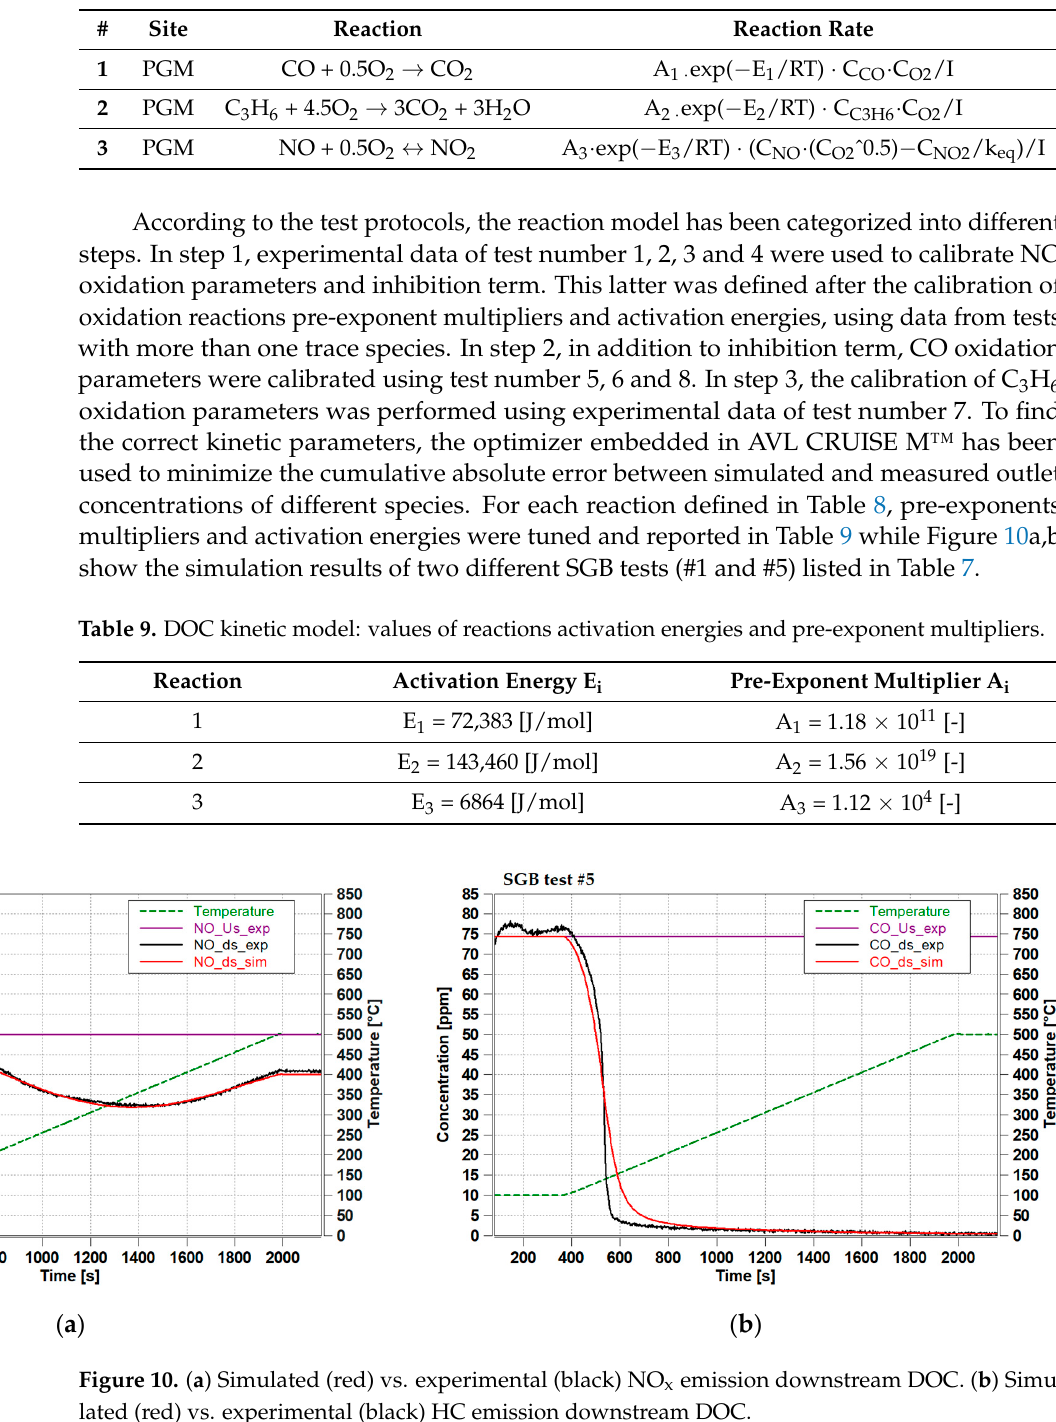
Table 8. Reaction model for the DOC component; A i : pre-exponent multiplier, E i : activation energy, C xy : concentration, I: inhibition term.